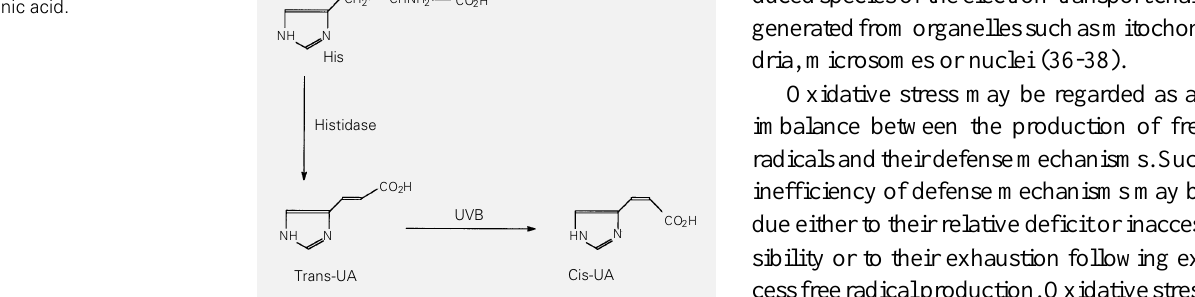
Figure 4 - Photoisomerization of urocanic